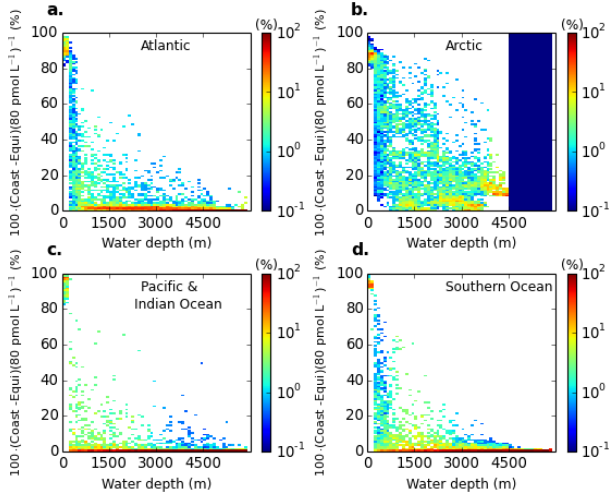
− Equi Figure 5. Histograms of 100 · Coast surface concentrations [%] 80pmolL − 1 for different local water depths in the Atlantic Ocean (a) , Arctic Ocean (b) , Pacific and Indian Ocean (c) , and Southern Ocean (d)